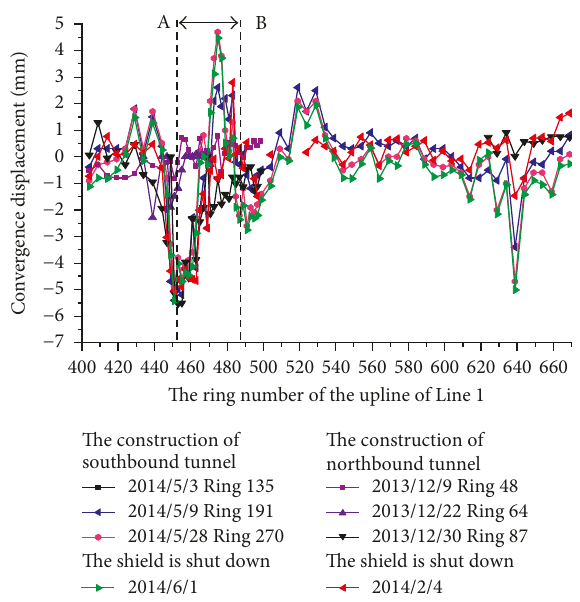
Figure 11: Convergence displacement of the existing tunnel.